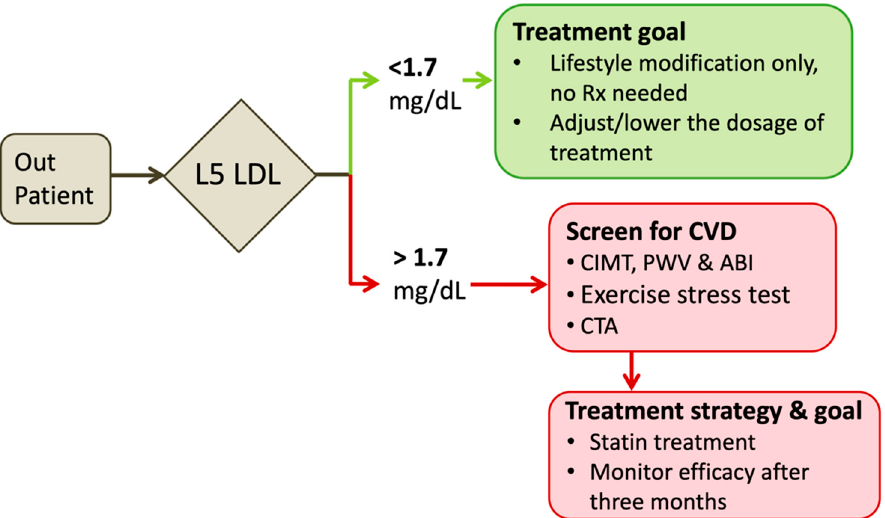
Figure 2. Reference ranges of L5 LDL and the strategy of statin treatment. Examining the plasma levels of L5 LDL can be useful to determine (1) whether to receive statin or not, (2) more detailed physical exams for cardiovascular functions and lesions, (3) the treatment strategy and goal. Rx: medical prescription; CIMT: carotid intima-media thickness; PWV: pulse wave velocity; ankle-brachial index; CTA: computed tomography angiography.